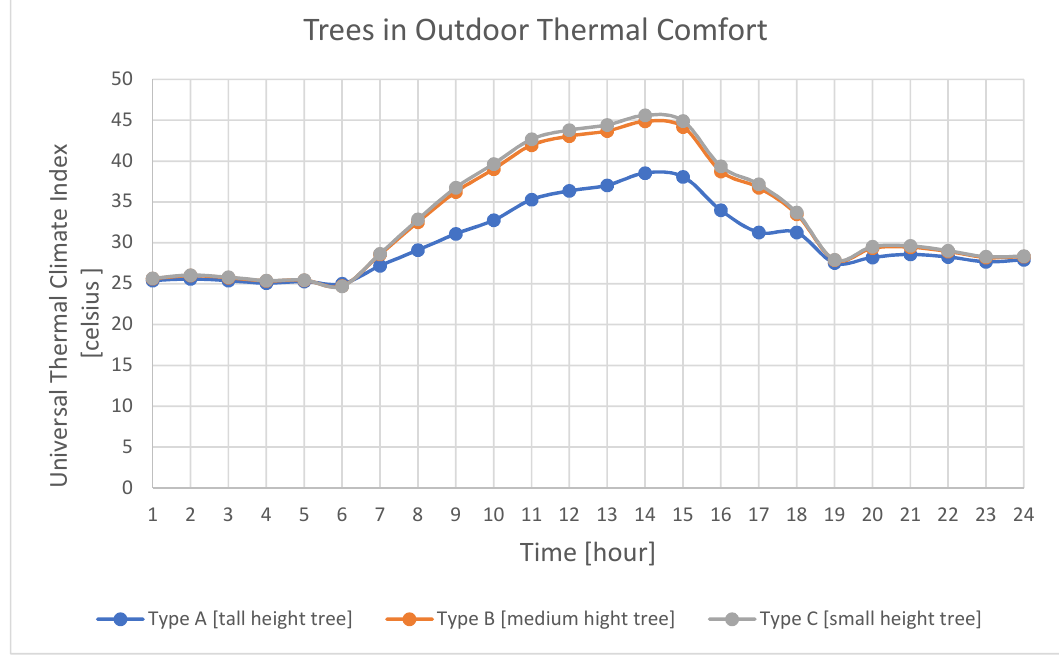
Figure 8. Trees in Outdoor Thermal Comfort measurements according to tree type classes.